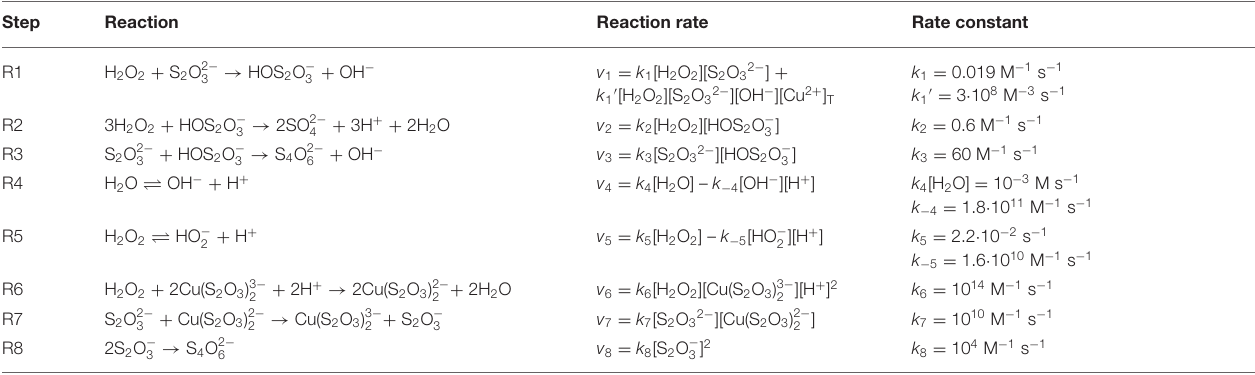
TABLE 1 | Model of the H 2 O 2 –S 2 O 2 − 3 –Cu(II)